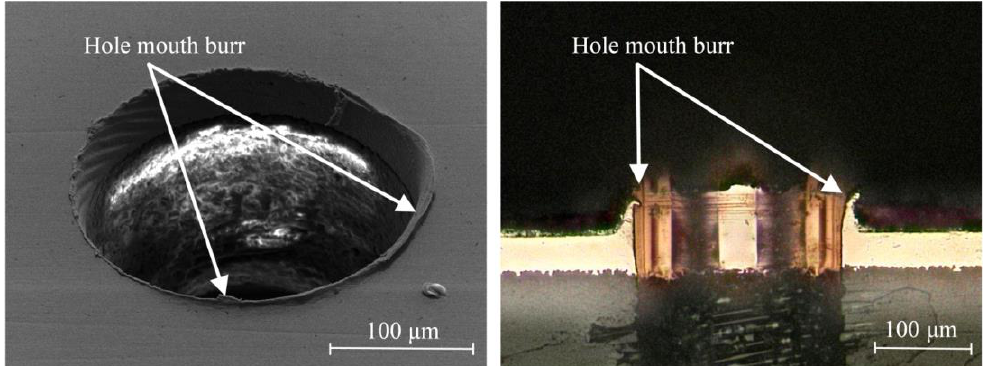
Figure 1. Hole mouth burr in printed circuit board (PCB)